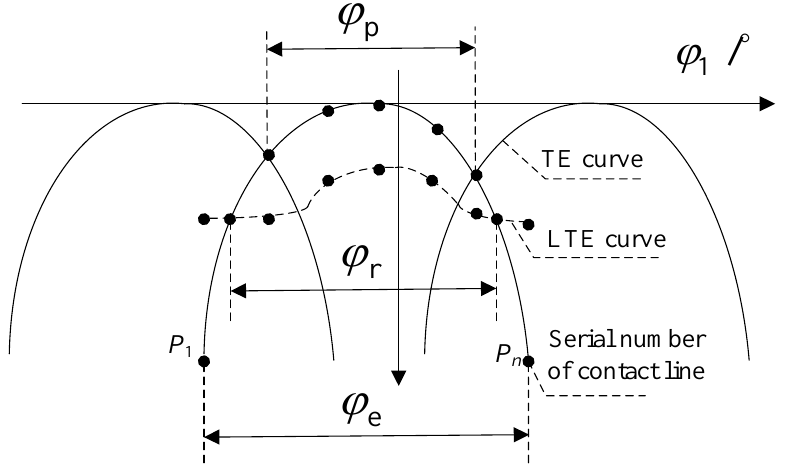
Figure 4. Geometrical transmission error and loaded transmission error curve.